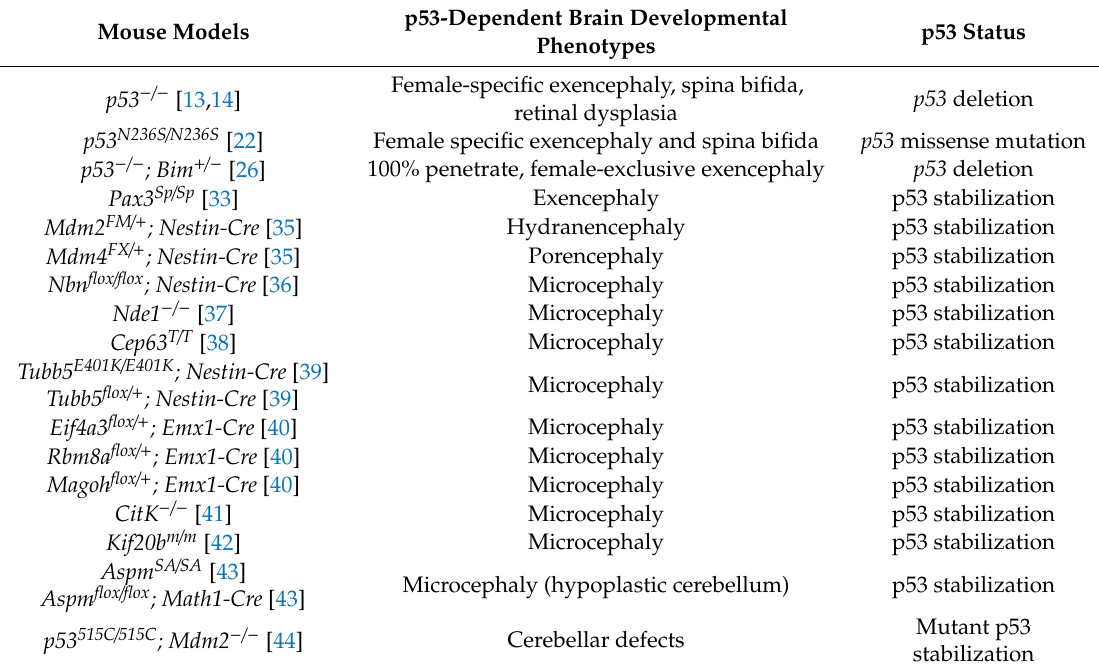
Table 1. Mouse models exhibiting p53-dependent brain developmental